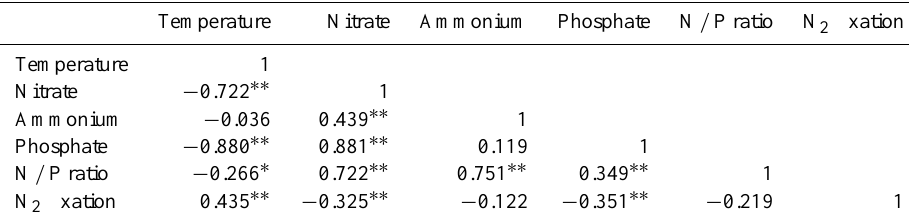
∗ p <0.05, ∗∗ p <0.01 N / P ratio denotes the ratio of (nitrate + nitrite + ammonium) to